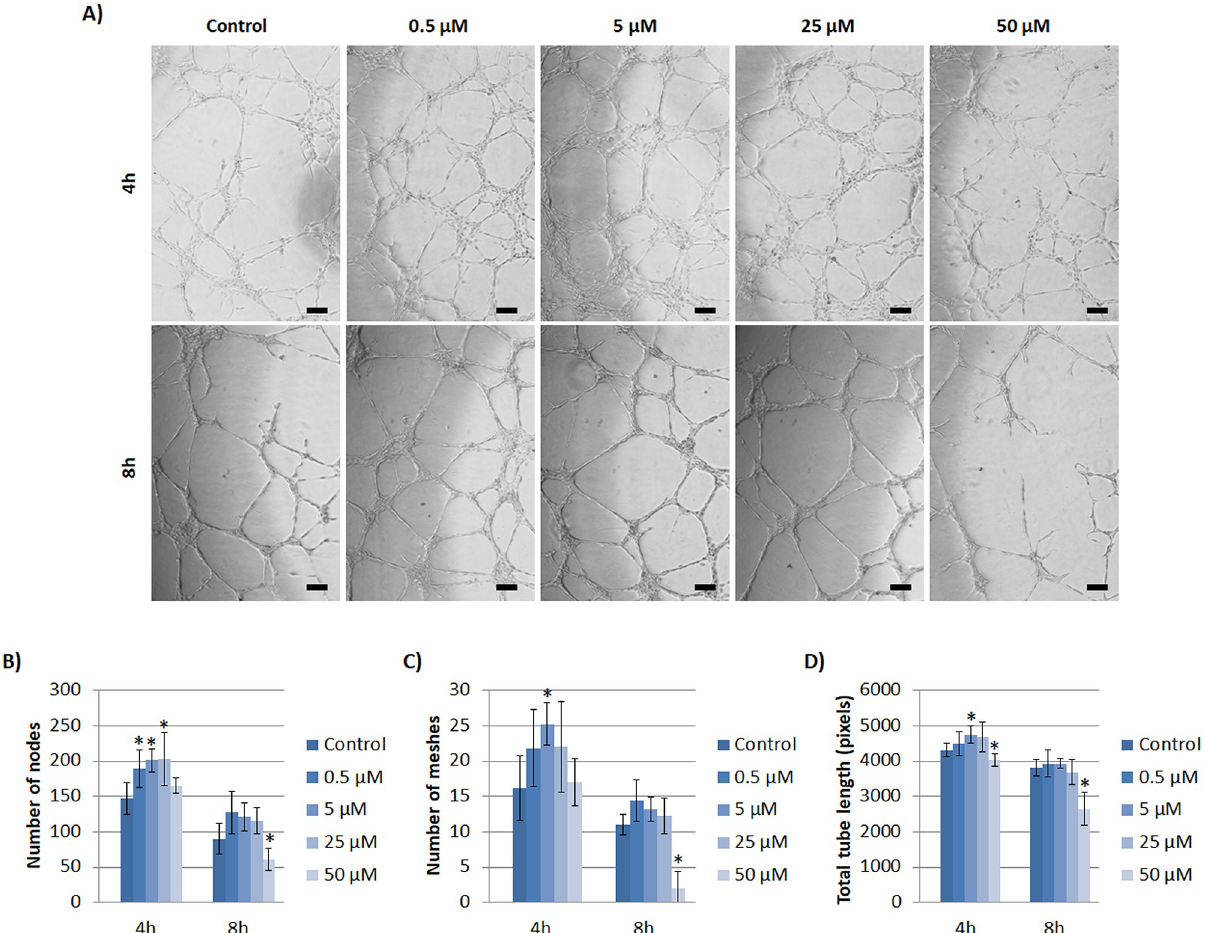
Fig 6. Effects of Co 2+ on tubule formation assay with HUVEC. (A) Images of tubules formed under different non-toxic concentrations of Co 2+ (0, 0.5, 5, 25 and 50 μ M) at 4 and 8 hours. (B) Analysis of number of nodes, (C) meshes and (D) total tube length of HUVEC under different Co 2+ concentrations at 4 and 8 hours. Scale bar = 50 μ m. Statistically significant differences were represented with � (p < 0.05).